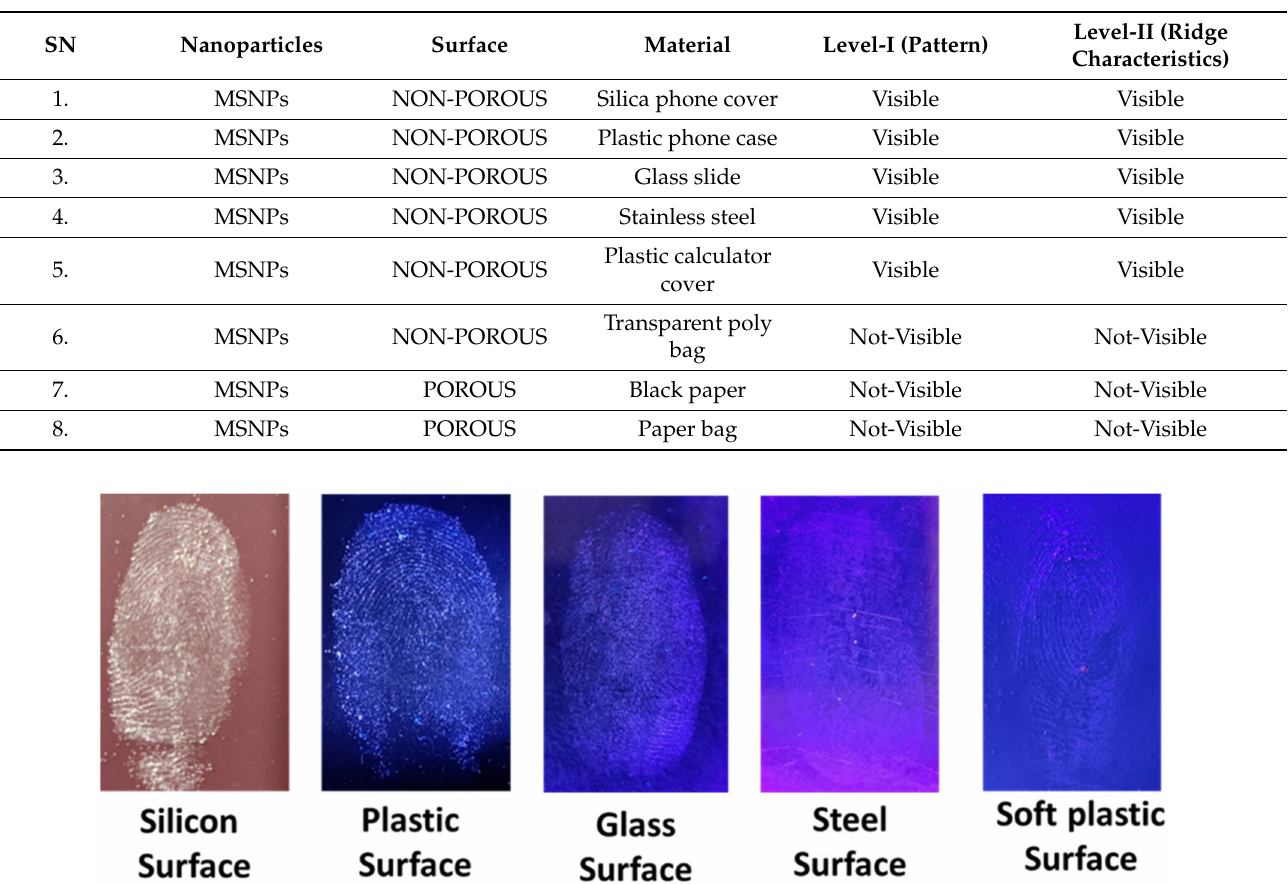
Table 1. Latent finger impressions developed using MSNs nanoparticles.